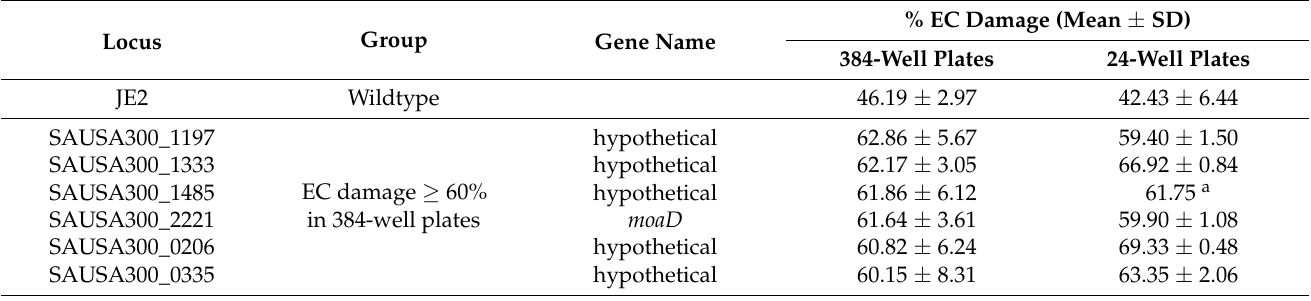
Table 3. Verification of EC damage of JE WT strain and selected mutants using 24-well plates